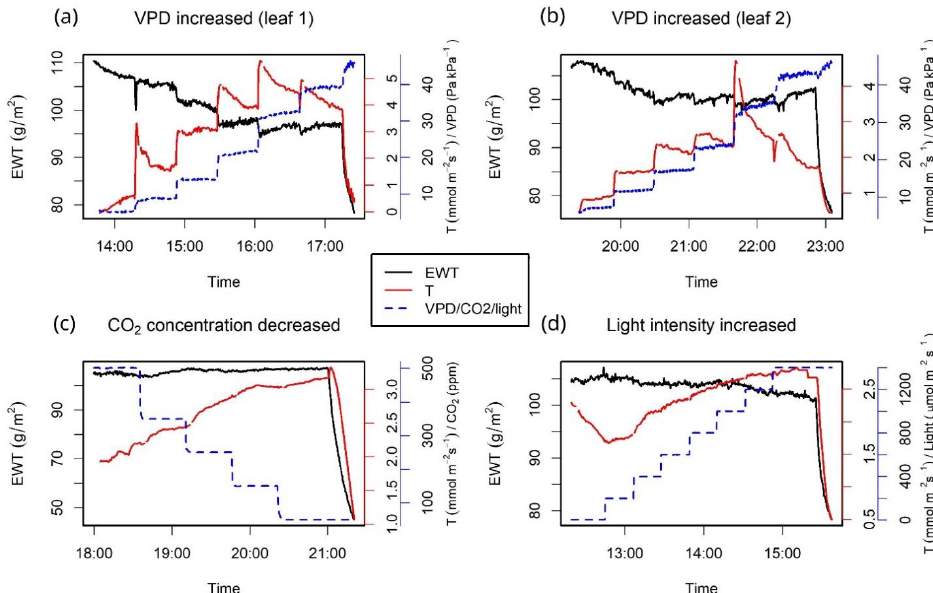
Figure 5. Variation in predicted equivalent water thickness (EWT, g m −2 , black line) and measured transpiration (mmol m −2 s −1 , red line) under incremental increases in ( a,b ) vapor pressure deficit (VPD, blue line) and constant CO 2 concentrations and light intensity, ( c ) CO 2 concentrations and constant levels of VPD and light intensity (blue line), and ( d ) light intensity and constant levels of VPD and CO 2 concentrations (blue line). EWT was predicted using reflectance at 1550 nm wavelength; decreases in EWT and transpiration indicate the timing of leaf petiole removal. A moving average of three measurements was used to filter noise.